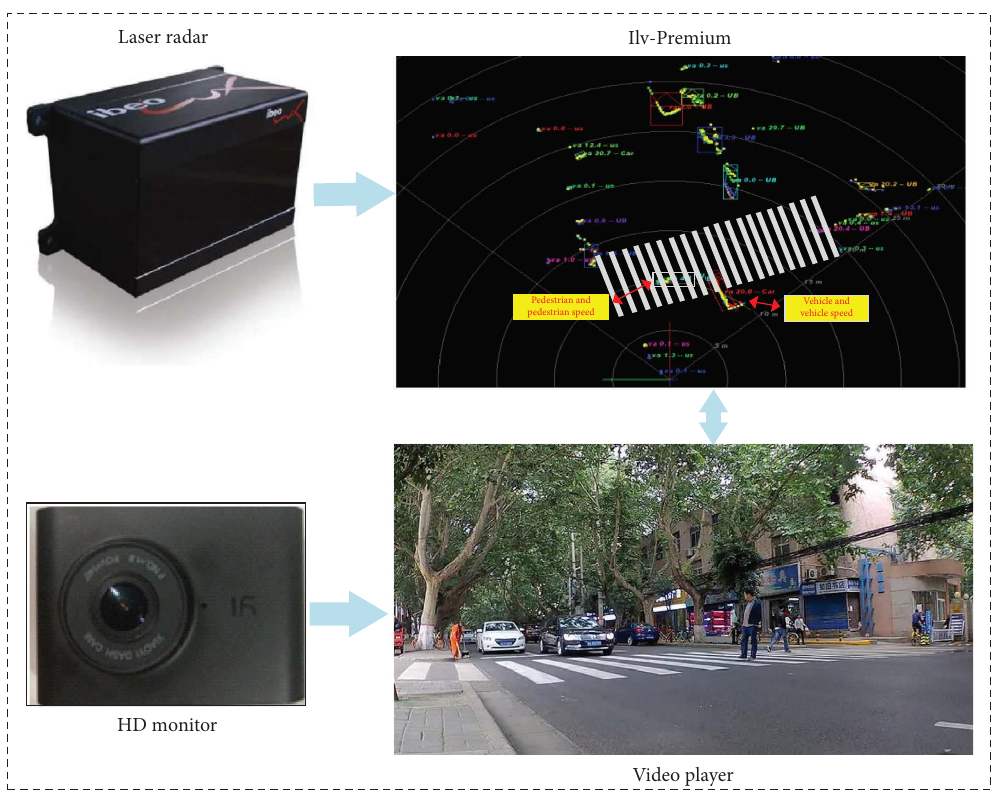
Figure 6: Laser radar and HD monitor: the upper part of the picture is a radar map, and the lower part is a camera map. Time syn- chronization between two